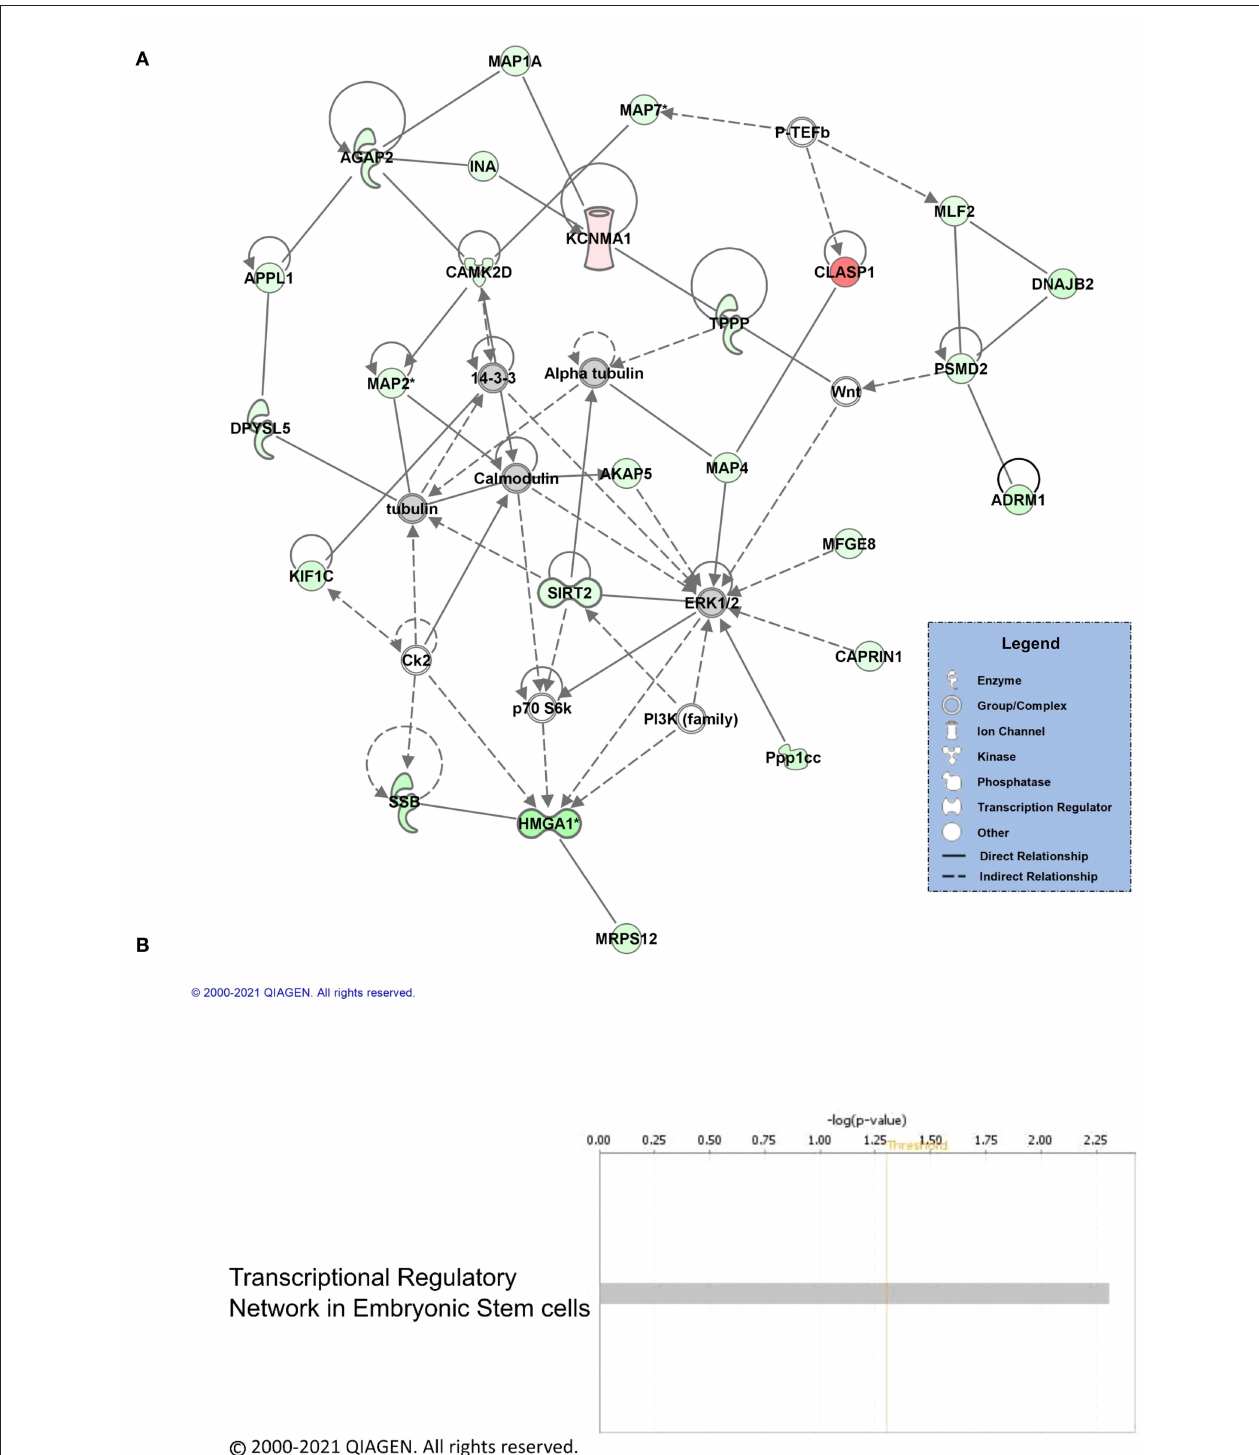
FIGURE 3 | Pathway and network analysis of proteins regulated by K48 polyubiquitin in the amygdala of females. (A) Network of associated proteins with high fold change ratio of K48 polyubiquitin targeting in females was created using IPA. The proteins with lower levels in K48-purified samples 1 h after training are shown in green and those that had enhanced levels are shown in red. Greater fold-changes have brighter colors. Solid lines indicate a direct relationship, while dotted lines refer to indirect relationships between the proteins. (B) The canonical pathway associated with proteins differentially polyubiquitinated (K48) in the female amygdala detected by